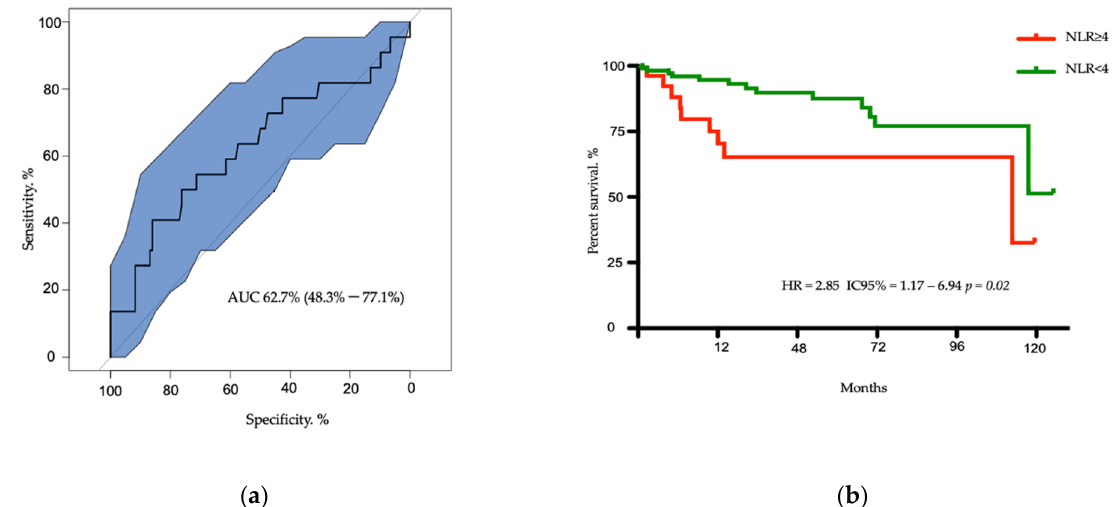
Figure 1. Determination of best cut off of neutrophil-to-lymphocyte ratio (NLR) and analysis of overall survival. ( a ) Receiver operating characteristic (ROC) curve for NLR to determine the best cut-off value: 4; AUC = 62.7) with a sensitivity of 41% and specificity of 86%. ( b ) Kaplan–Meier curves for patients overall survival according to NLR. Table 2. Univariate and multivariate analysis of variables for overall